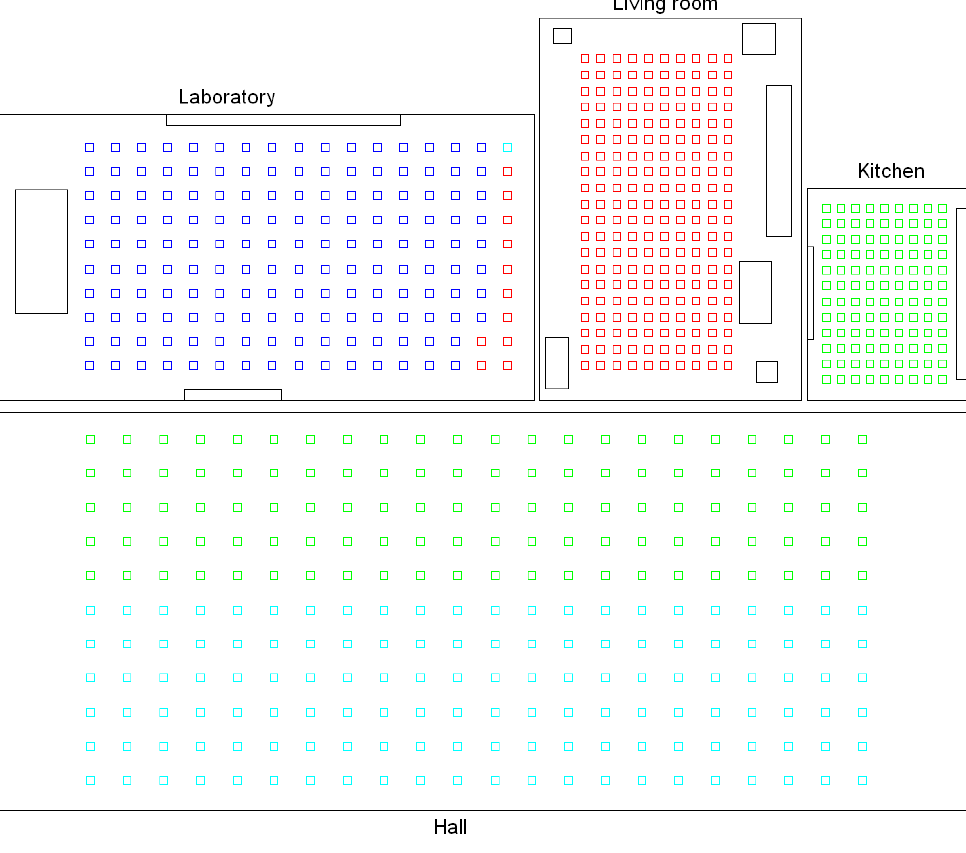
Figure 4. Results of the high-level clustering process using the spectral algorithm and gist with the Bielefeld dataset.